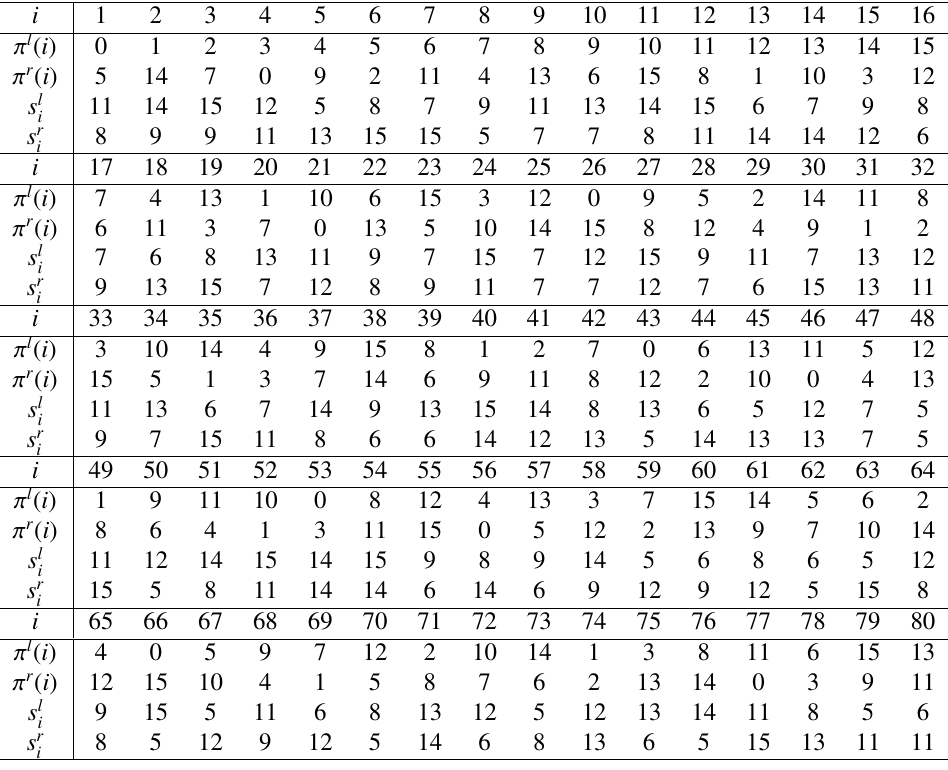
Table 2: Order of the Message Words and Rotation Values in